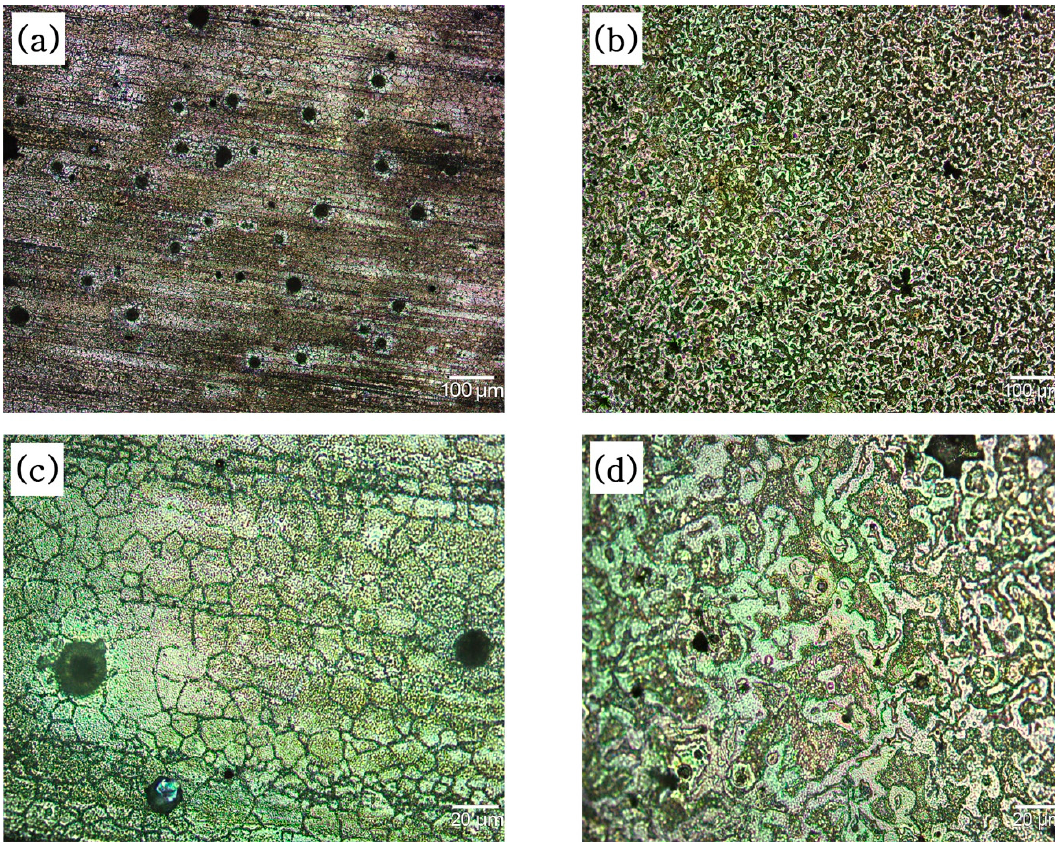
Figure 8. After corrosion microstructure of AZ91D produced by WAAM and casting: ( a , c ) AZ91D casted; ( b , d ) AZ91D WAAM.